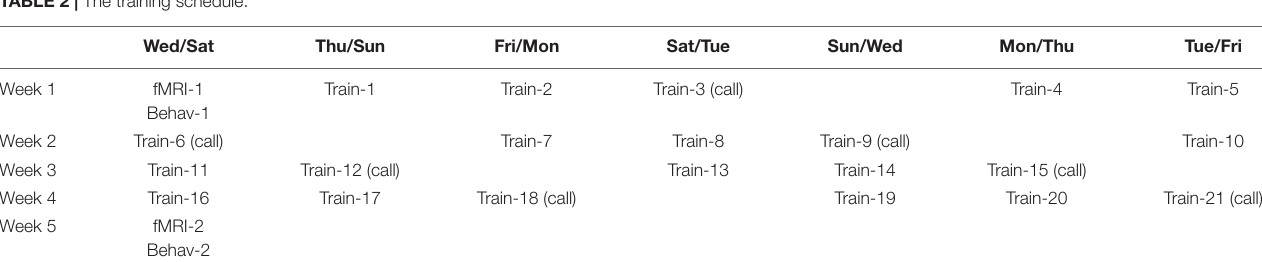
TABLE 2 | The training